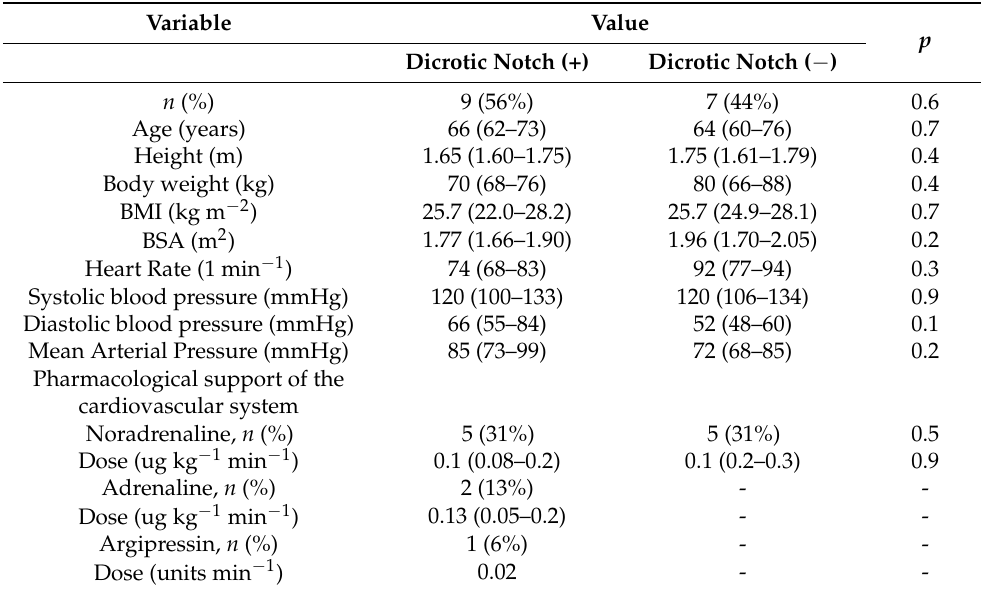
Table 2. Characteristics of selected demographic and clinical data depending on the presence of a dicrotic